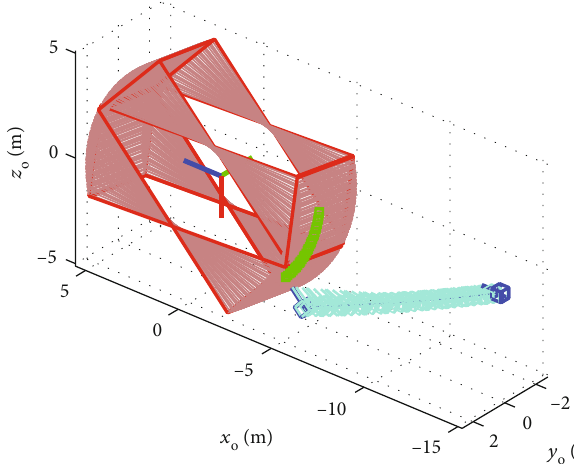
Figure 2: Optimal trajectories of all 388 neighborhood members. The radius of the sphere on the left is Δ r the ENVISAT with an attitude of t 0 . The red, blue, and green lines perpendicular to one another denote the + x , + y , and + z axes, respectively, of the orbital coordinate system S o .